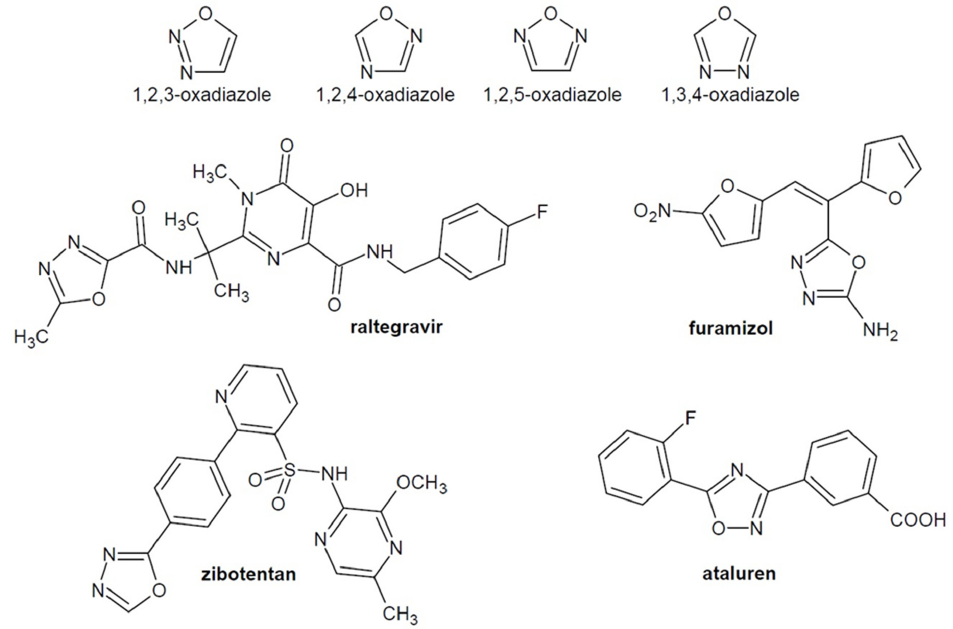
Figure 1. Isomeric forms of oxadiazole and examples of known drugs containing an oxadiazole ring. The most promising structures are 1,3,4-oxadiazole derivatives. At the end of the nineteenth century, the first derivatives of 1,3,4-oxadiazole were synthesized. The meth- ods of obtaining the new structures were multidirectional, including reactions of appro- priate hydrazides and phosgene [9], thermal cyclization of 1-acylsemicarbazides [10] or cyclization of 1,2-diacylhydrazines by the action of dehydrating agents [11]. The